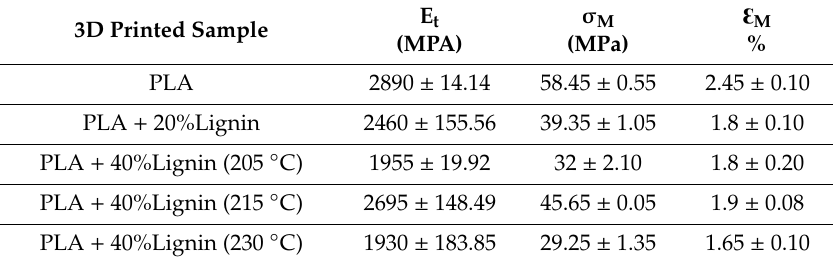
Table 1. Mechanical properties of PLA and PLA / Lignin